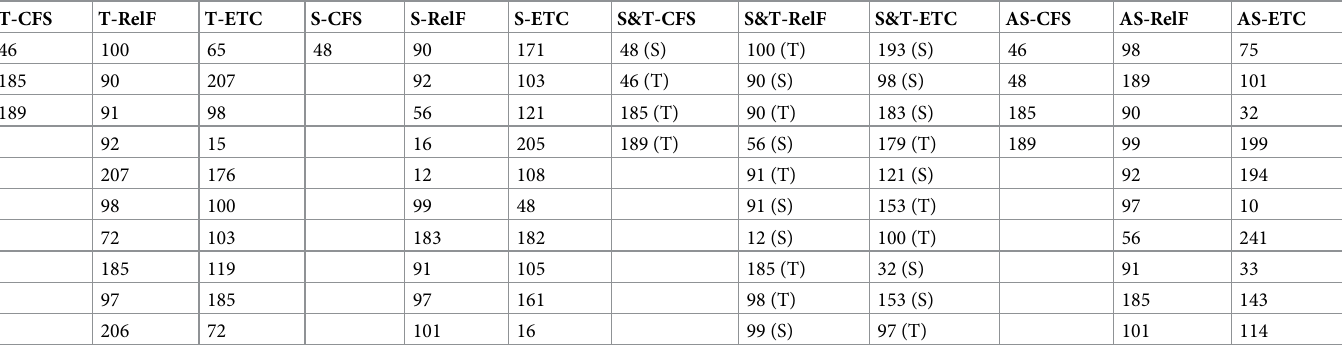
Table 2. Top 30 selected features for each feature selector.